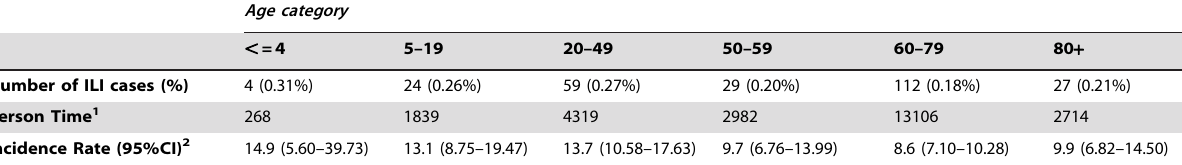
Table 2. Number and rate of influenza like illness (ILI) cases.